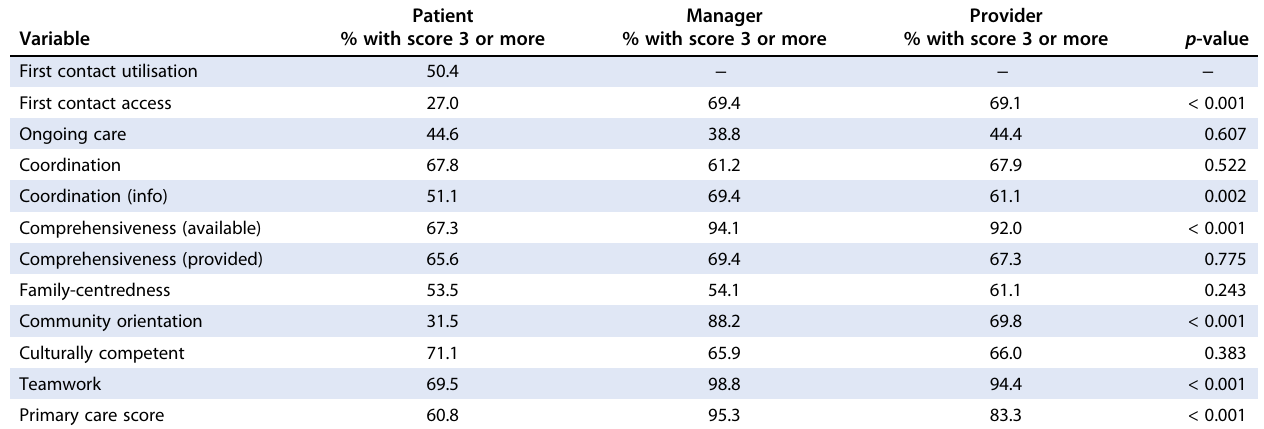
Table 5: Comparison of % of scores >=3 between respondent groups for different primary care domains